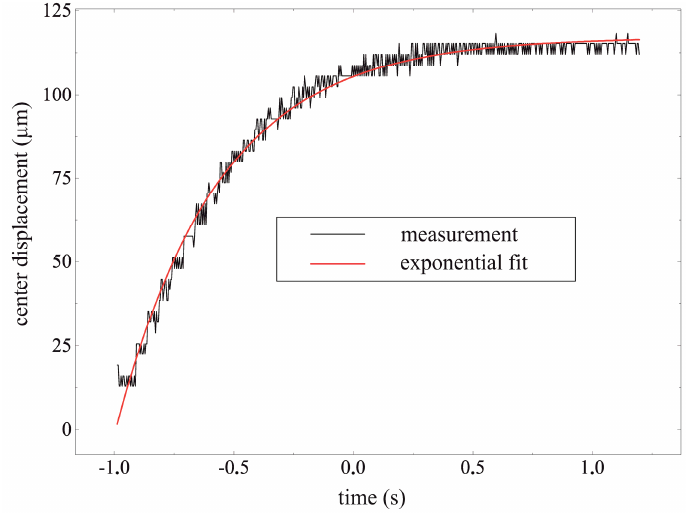
Figure 17. Time dependent center displacement of the storage chamber membrane.